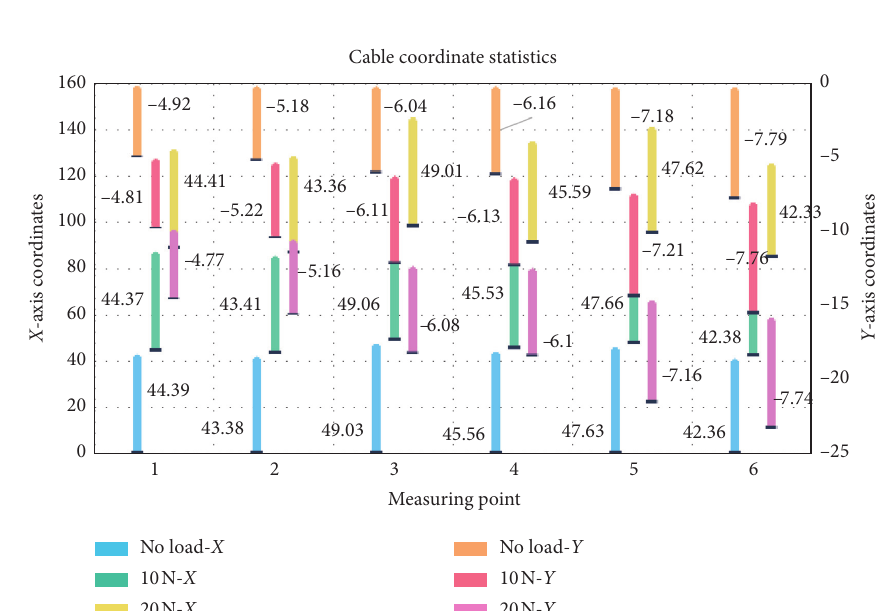
Figure 3: Coordinate statistics of bridge cable